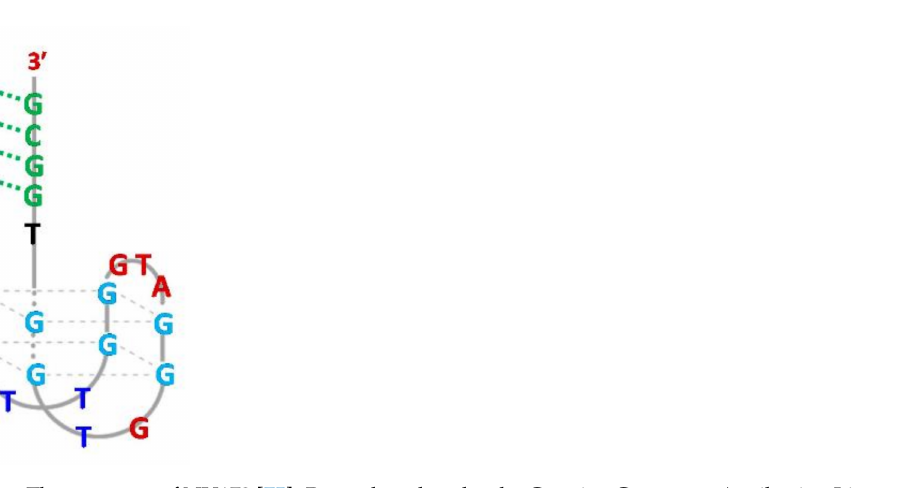
Figure 6. The structure of NU172 [75]. Reproduced under the Creative Commons Attribution